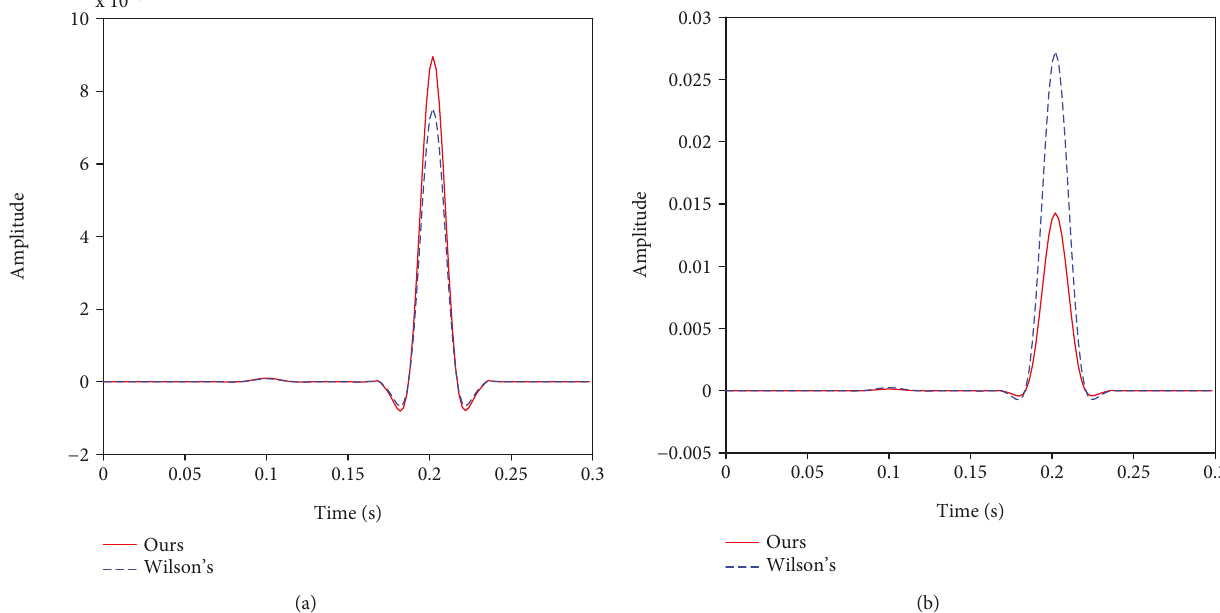
Figure 4: The inversion results by our scheme and Wilson ’ s scheme. (a) P-wave dispersion gradients I The value by Wilson ’ s schemes is less than that by ours at the peak; (b) mixed dispersion gradient I by Wilson ’ s. The value of I gradient I b